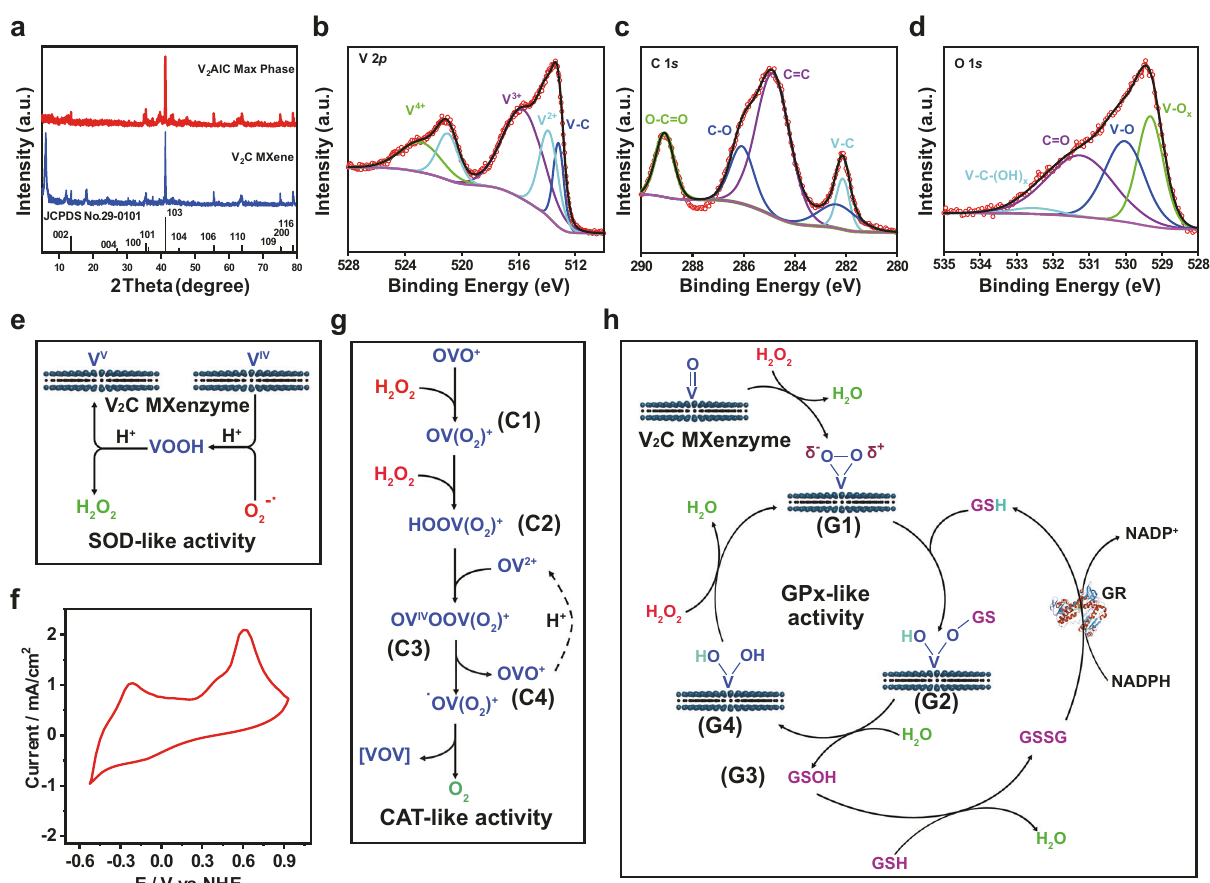
-0.6 -0.3 0.0 0.3 0.6